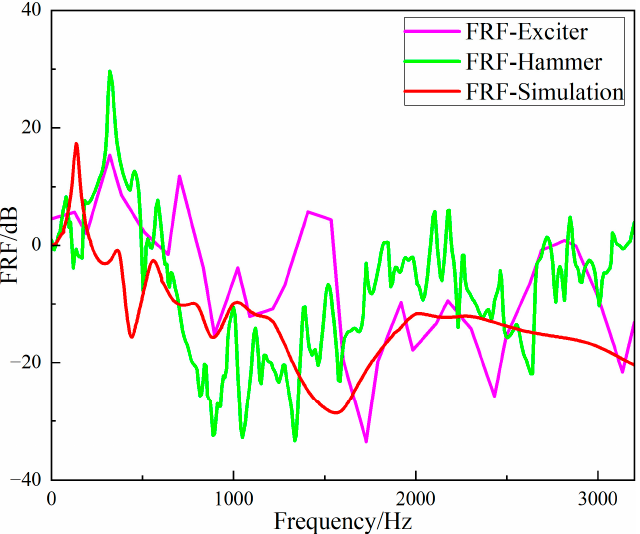
Figure 26. Comparison of FRF values between simulation and experiment.